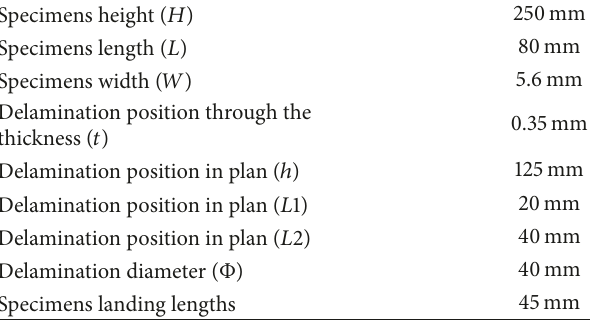
Table 1: Geometrical description of the tested specimens.